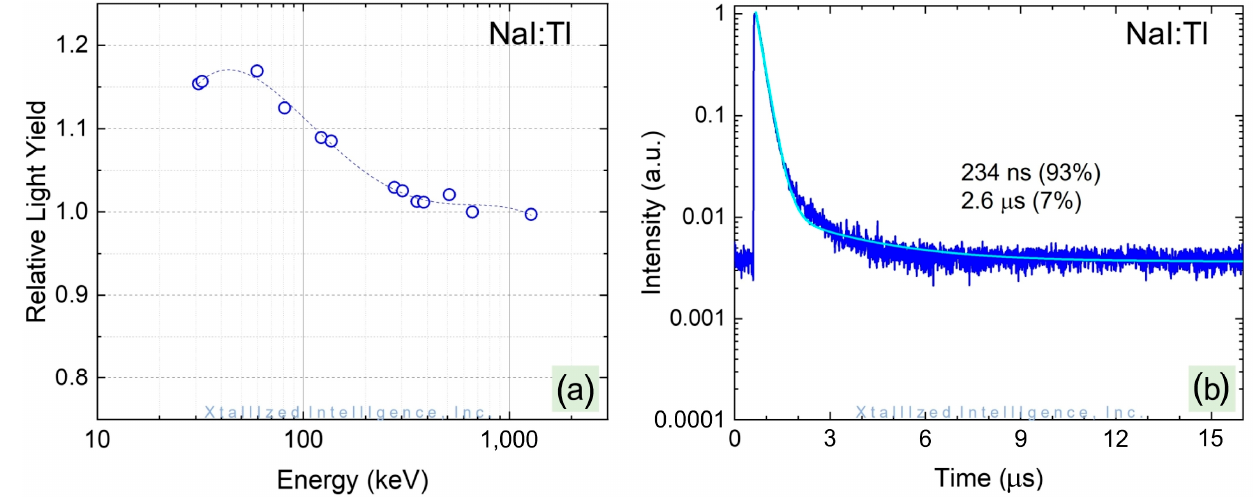
Figure 8. ( a ) Nonproportionality data for NaI:Tl grown by XI, Inc. ( b ) Decay time profile for NaI:Tl